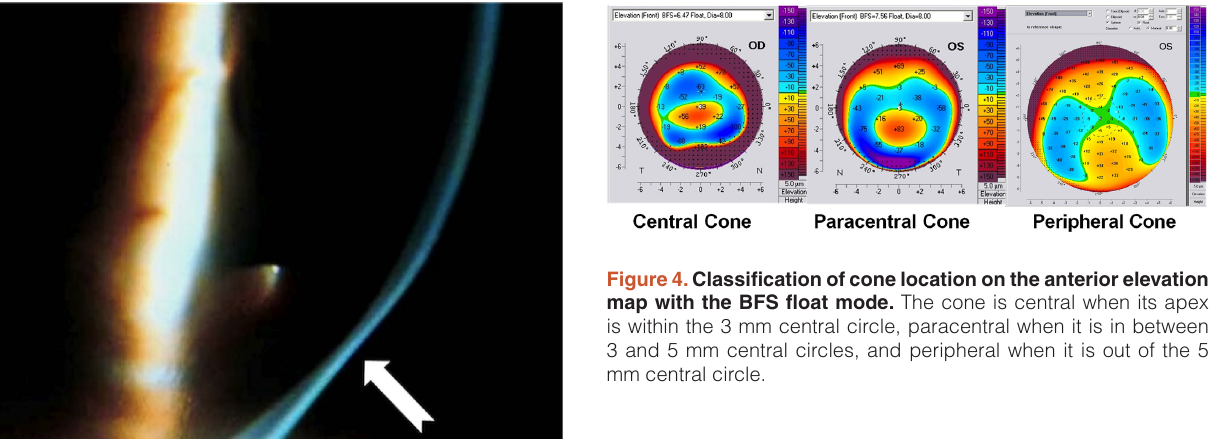
(BFS) float mode to localize the cone and to identify the kissing birds sign. The cone was considered central, paracentral or periph-